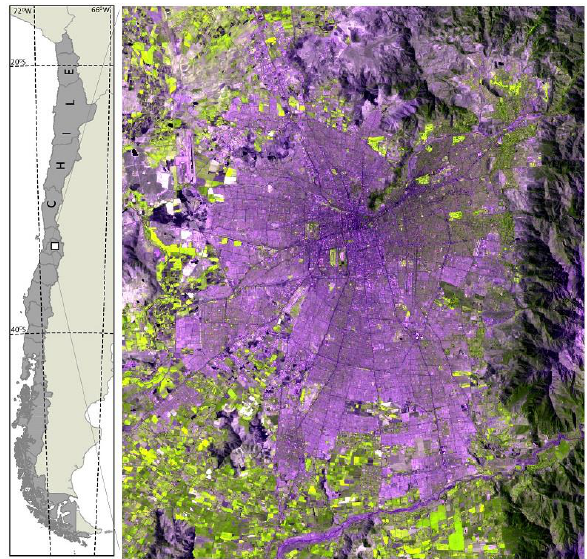
Figure 1. Study area: Santiago de Chile. Landsat-8 OLI image from January 28 th 2015, RGB 753.